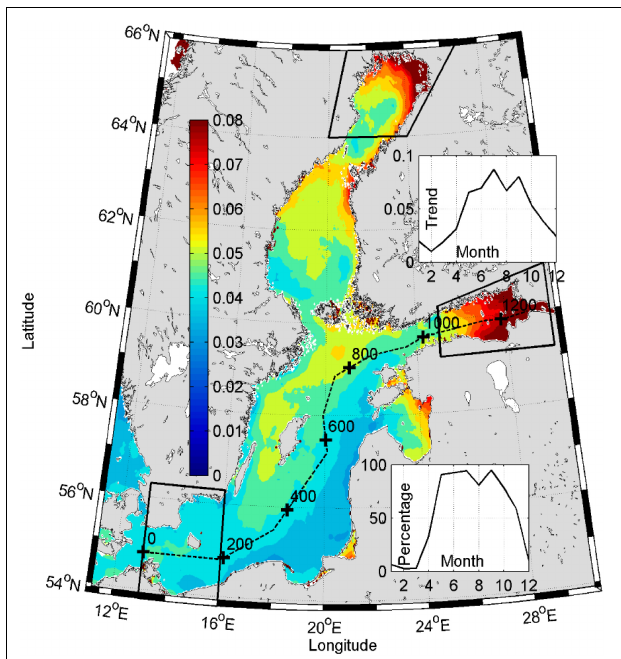
FIGURE 3 | Sea surface temperature trend in ◦ C year - 1 from 1982 to 2016. The upper inlay shows the mean seasonal temperature trend ( ◦ C year - 1 ) in the entire Baltic Sea. The lower inlay shows by months the percentage of the area, where positive temperature trends were significant ( p ≤ 0.05). The dashed line shows the transect, which is shown in Figure 8A . Numbers indicate the distance from the southwestern end of the transect Boxes show areas of Arkona/Bornholm, Northern Bothnian Bay, and Eastern Gulf of Finland. Data from these areas are used in Figures 8B–D